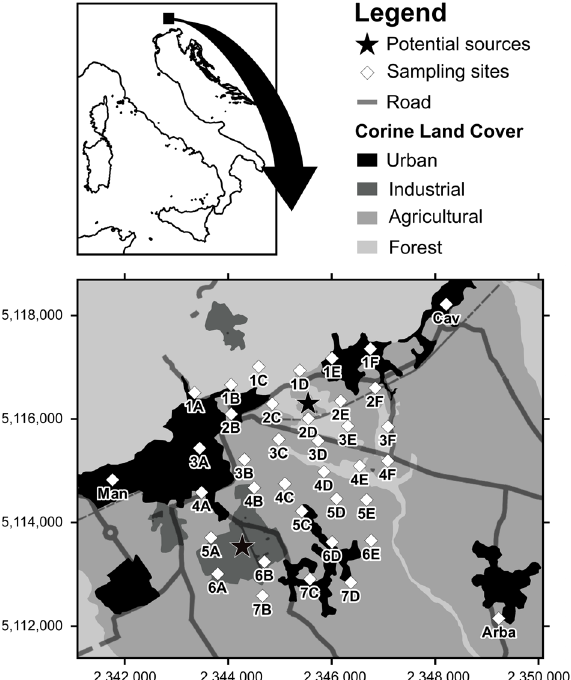
Figure 1. Geographical localization of the study area with the 37 sampling sites ( ◇ ). Black stars near to sites 2D and 5A indicate the cement ‐ plant and the industrial park, respectively. UTM 33N coordinates are reported on the x, y axes.